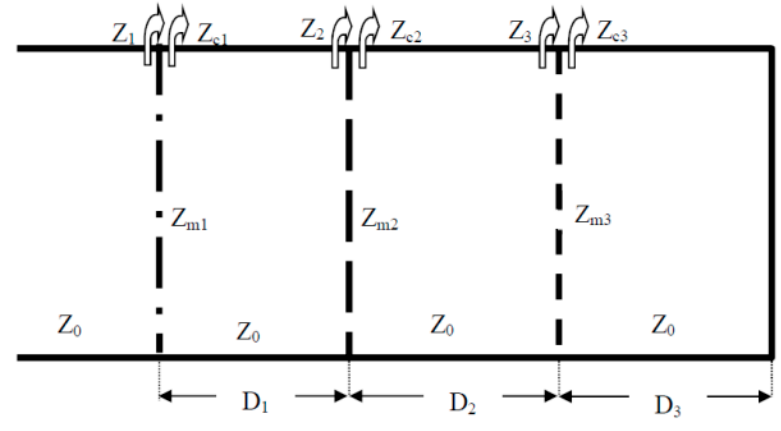
Figure 26. Sketch of a TL-MPP at normal incidence.